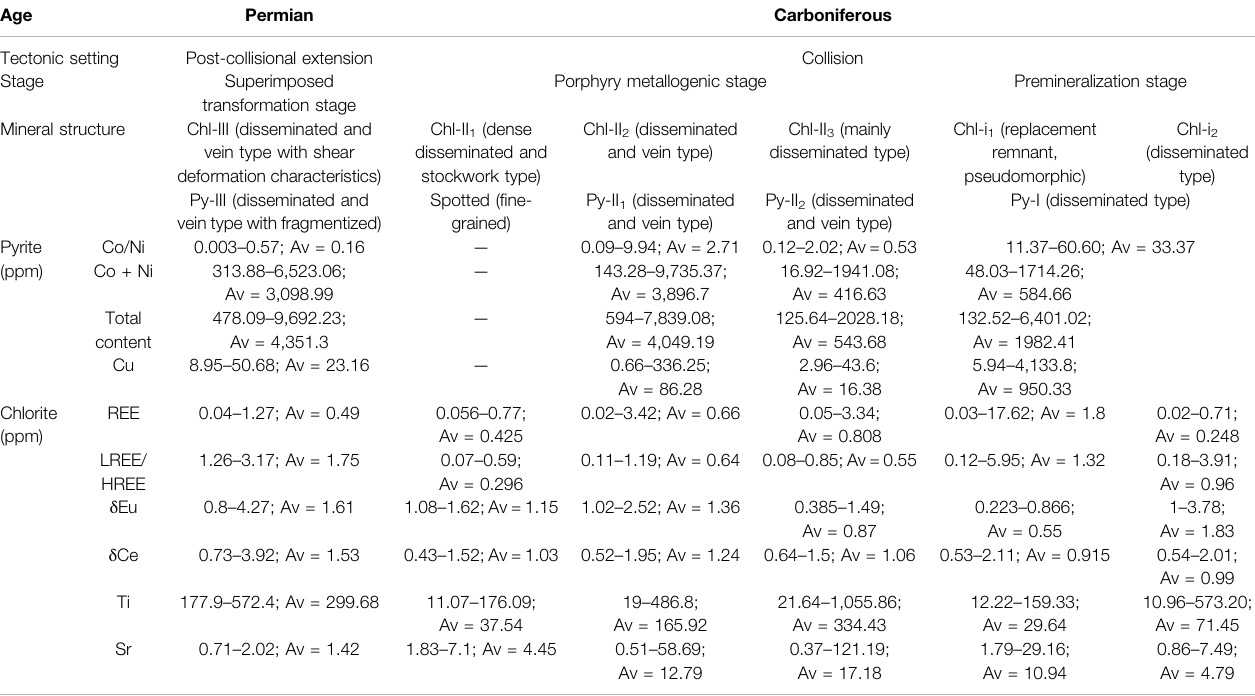
TABLE 3 | elationship table between the sequence of events and the chemistry of pyrite and